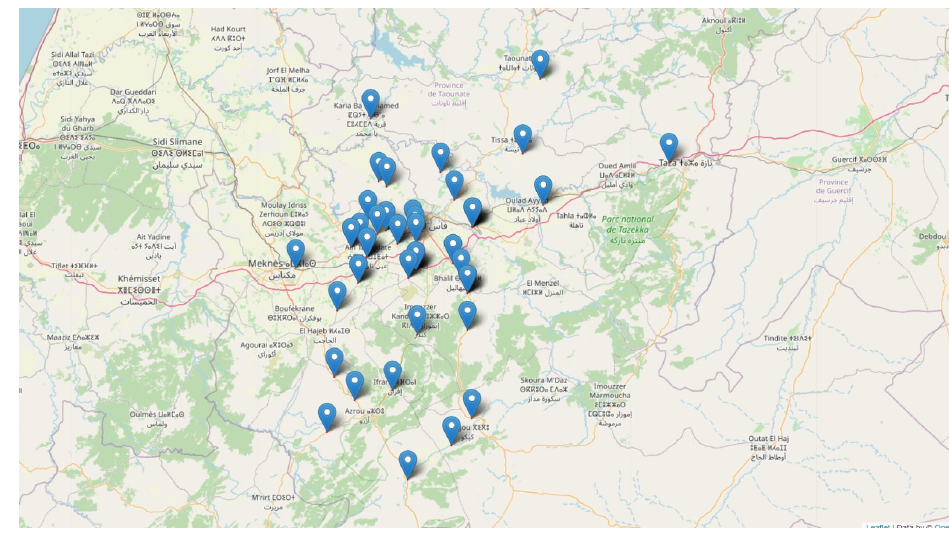
Figure 11. Leaflet Map of EVCS.